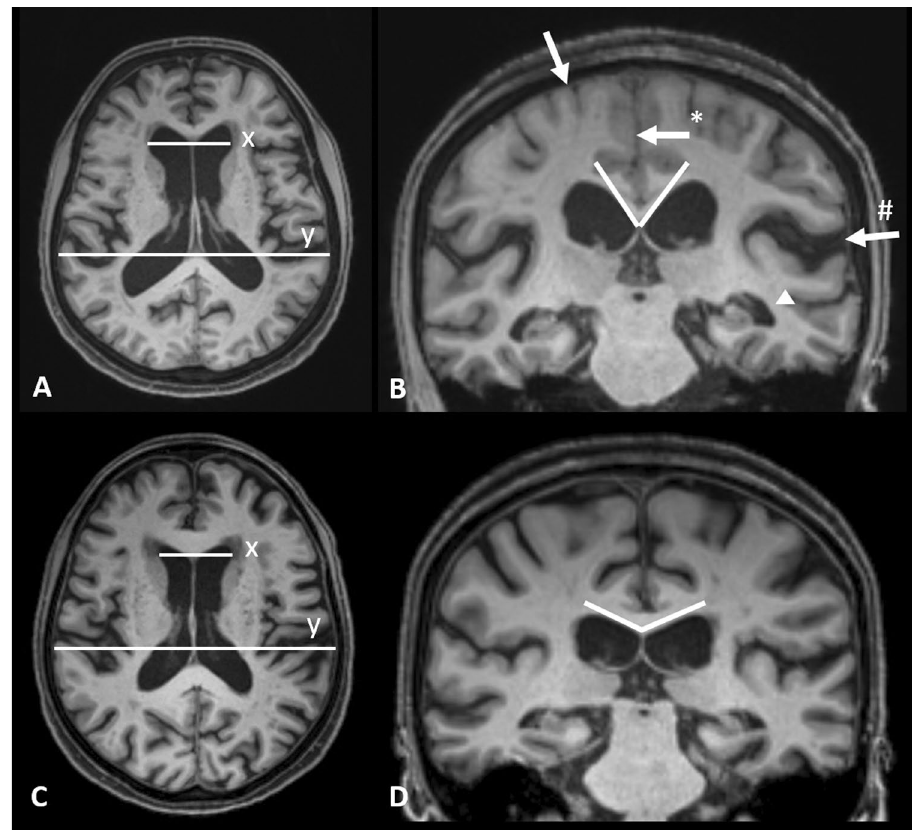
Figure 3. Axial and coronal T1 MPRAGE reformats in a 66 year old female patient with presumed iNPH ( A , B ) with iNPH Radscale 11: enlarged lateral ventricles ( A , Evans index x/y = 0.31), widening of the Sylvian fissure ( B , arrow#) and temporal horn of the lateral ventricles (arrowhead), narrowed parafalcine sulci ( B , arrow*) and narrowed sulci along the vertex ( B , arrow) and a callosal angle of 61° (white lines in B ). 79 years old female control patient ( C , D ) with iNPH Radscale 4 for comparison: Evans index of 0.26 ( C , x/y) and a callosal angle of 132° ( D , white lines) in the absence of iNPH-typical features shown